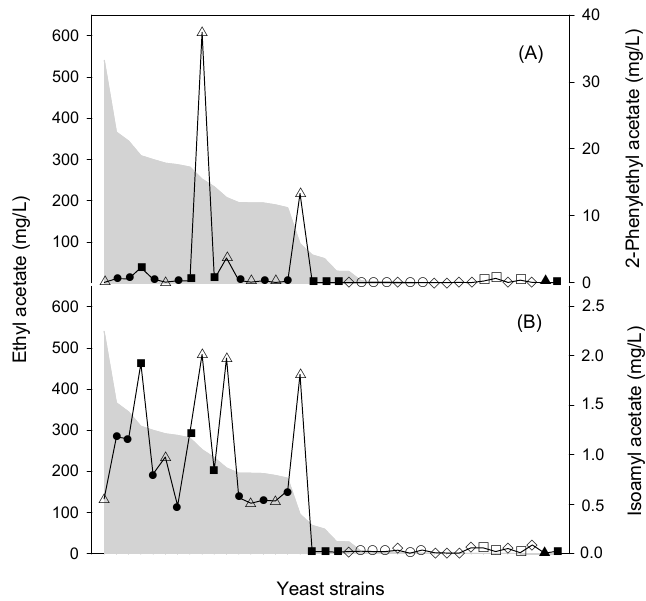
Figure 2. Production of acetate esters by non- Saccharomyces yeast strains. ( A ) 2-Phenylethyl acetate (symbols; right axis). ( B ) Isoamyl acetate (symbols; right axis). Ethyl acetate is represented in both panels as an area plot (left axis). Strains: Pichia anomala (seven different strains), P. membranifaciens (seven different strains), P. fermentans (one strain), Candida spp, Hanseniaspora spp, Torulaspora spp, Zygosaccharomyces spp. Adapted from Reference [59].